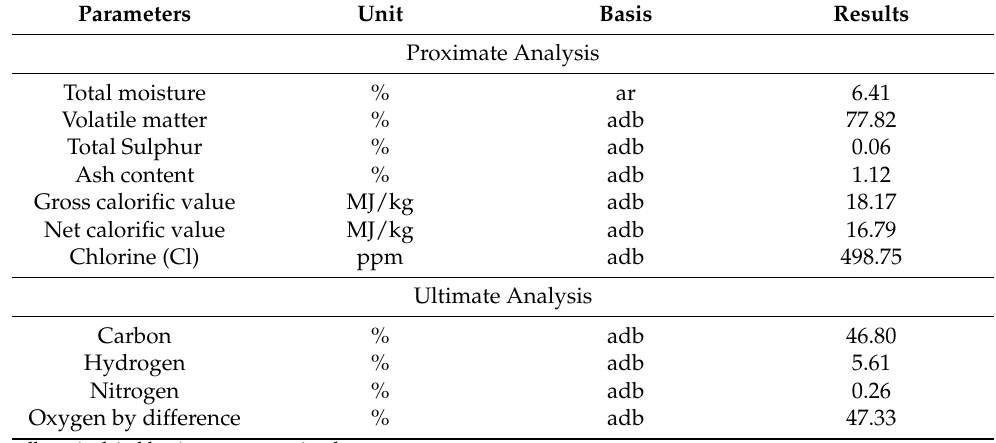
Table 1. Proximate and ultimate analysis of wood pellet.